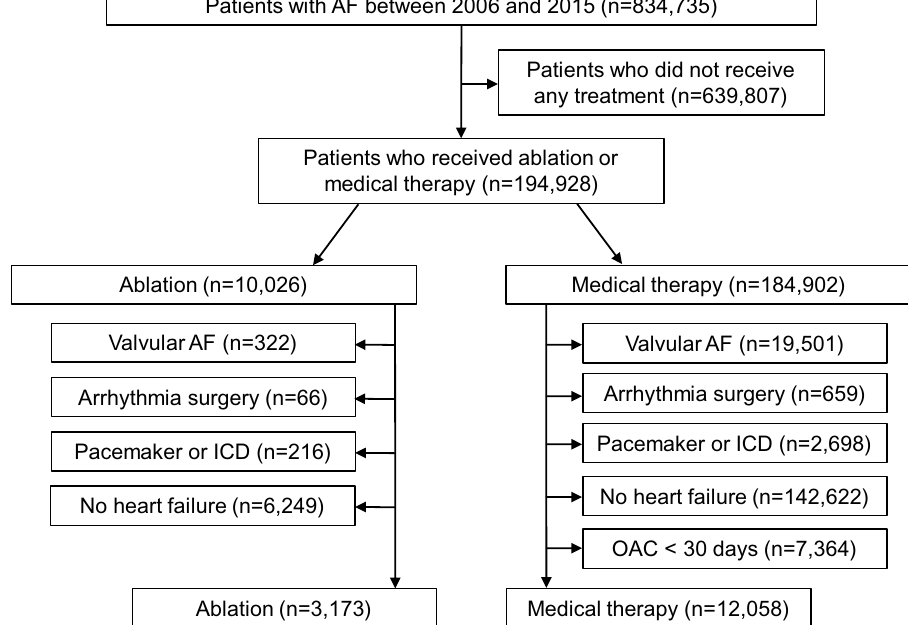
Figure 1. Flowchart of the enrollment and analysis of the study population. AF, atrial fibrillation; ICD, implantable cardioverter-defibrillator; OAC, oral